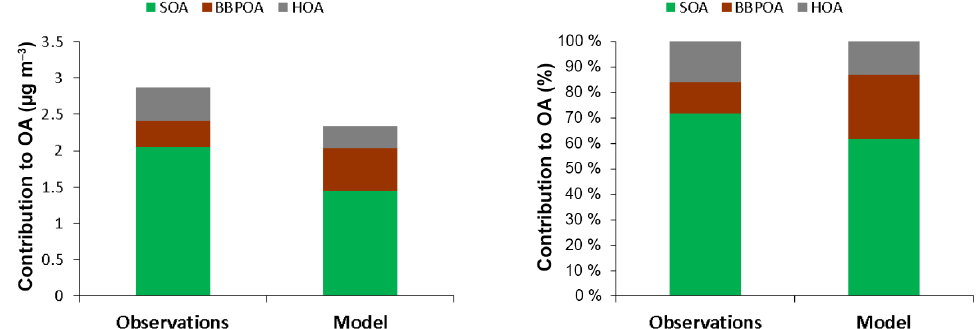
Figure 7. Measured and modelled average absolute (left panel) and relative (right panel) contributions of HOA, BBPOA and SOA to OA concentrations for all 11 sites for the period between 25 February and 26 March